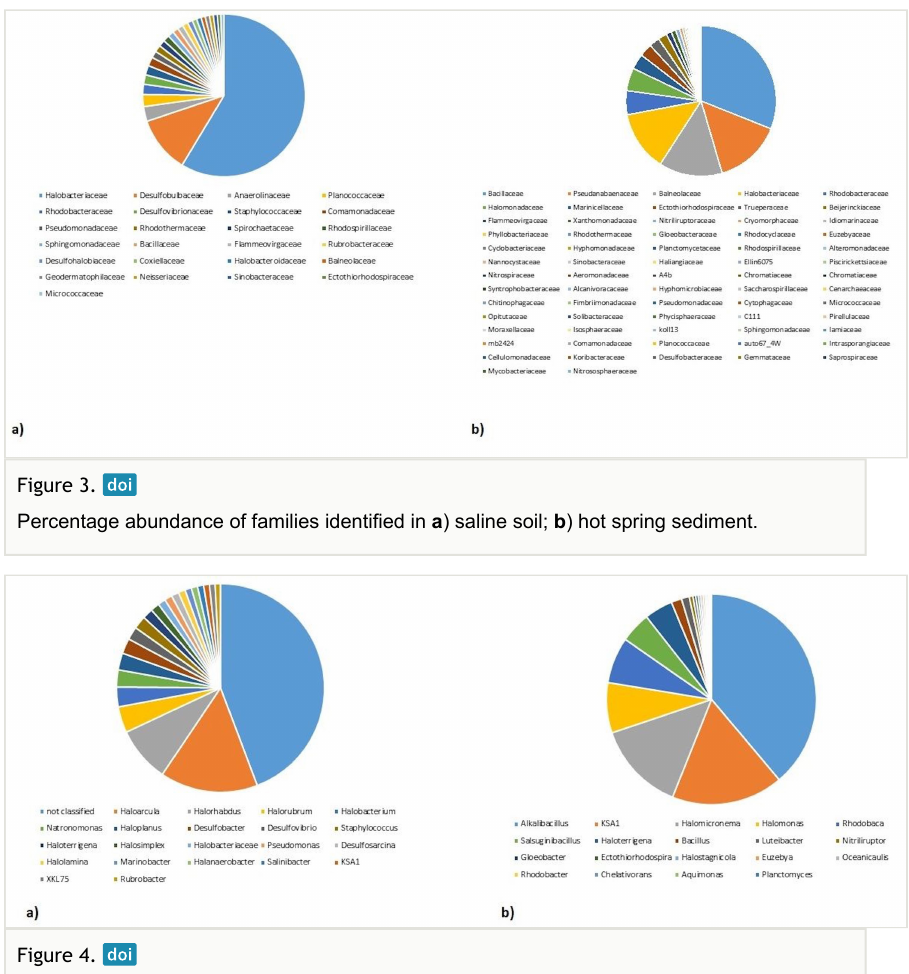
Figure 4. Percentage abundance of genera identified in a ) saline soil; b ) hot spring